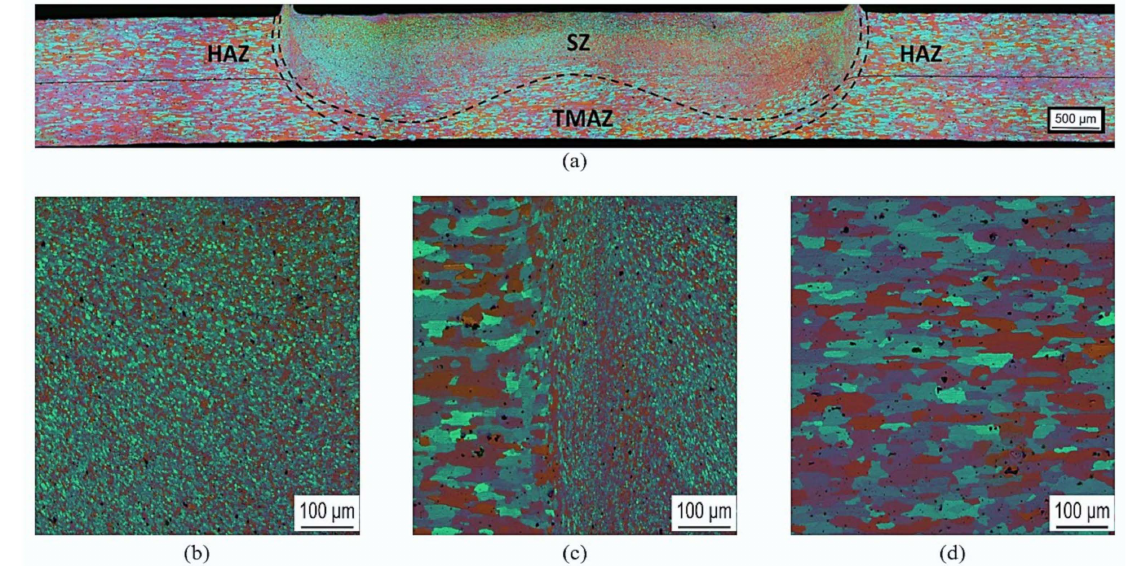
Figure 8. Microstructure of refill FSSW joint. ( a ) Cross-section of the weld; ( b ) stir zone (SZ); ( c ) thermo-mechanically affected zone (TMAZ) and SZ interface; ( d ) base material.